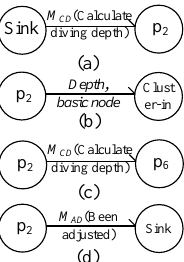
Figure 9. Message flow during position adjustment. ( a ) Initialization phase of position adjustment; ( b ) Phase of position adjustment; ( c , d ) End of position adjustment.